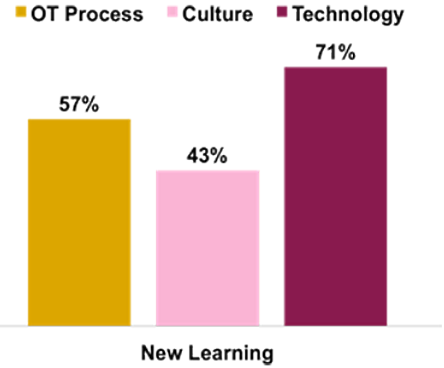
Figure 1. Reported new learning in evaluated outcome